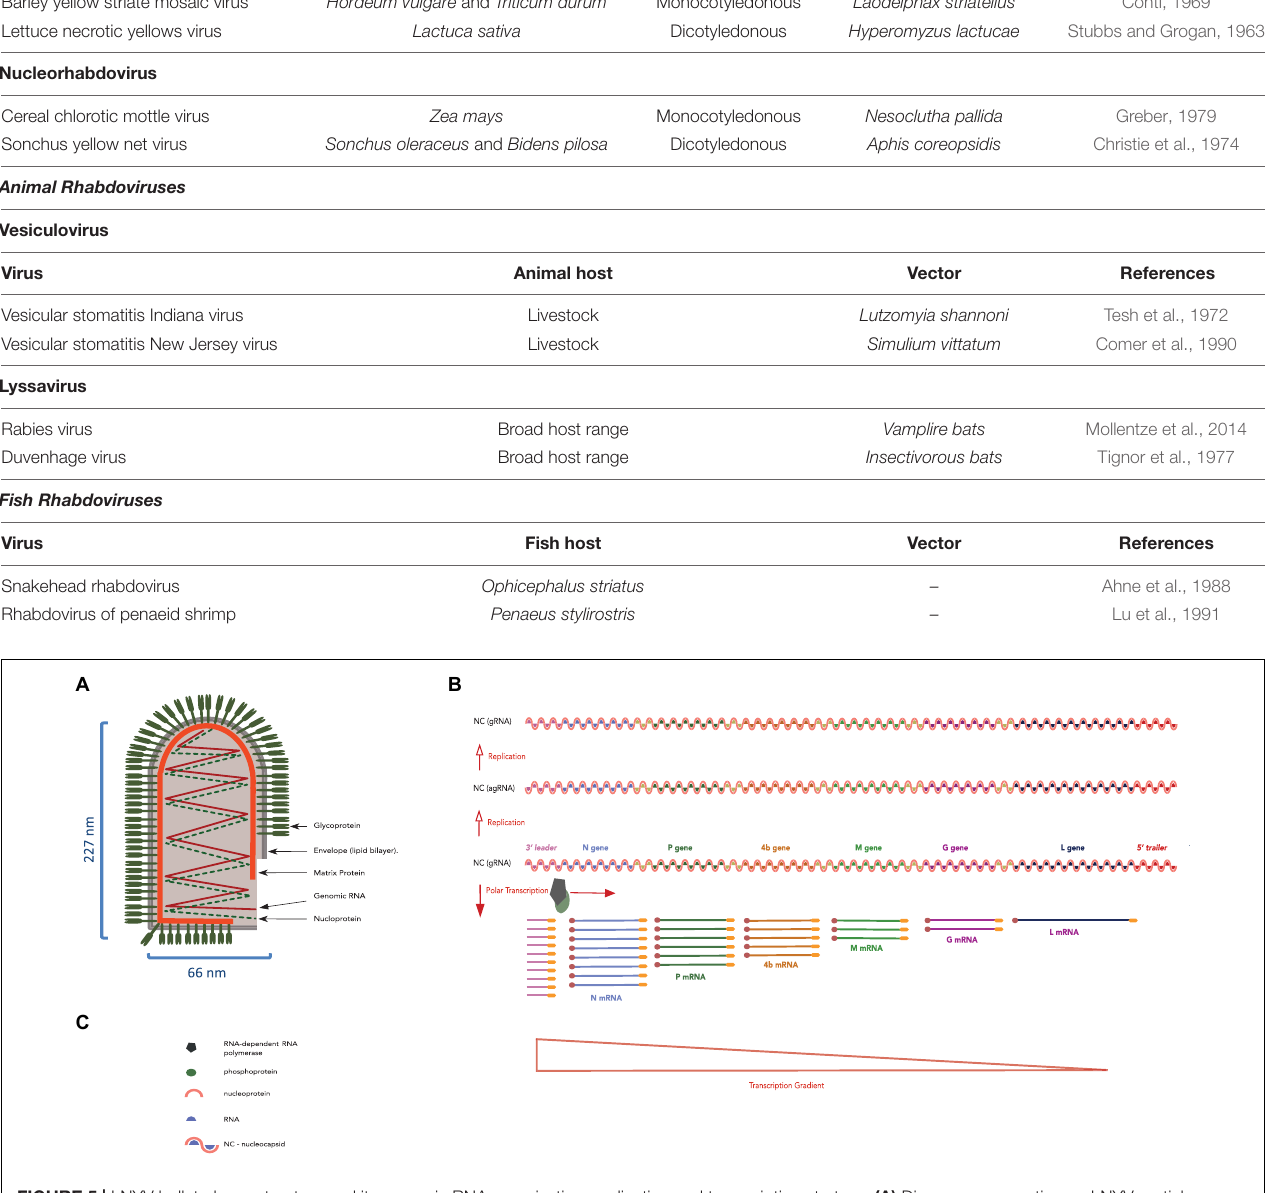
FIGURE 5 | LNYV bullet-shape structure and its genomic RNA organization, replication and transcription strategy. (A) Diagram representing an LNYV particle showing the transmembrane glycoprotein, lipid bilayer, matrix protein, and genomic RNA together with the nucleoprotein forming the ribonucleoprotein coil. (B) LNYV gRNA (negative-sense) showing the 3 (cid:48) leader , the N, P, 4b, M, G, and L genes, the 5 (cid:48) trailer (sequential genes separated by a gene junction) and the transcription gradient. Genomic RNA is first replicated into agRNA (positive-sense), which is used as template for the production of (accumulating amounts of) progeny gRNA (negative-sense). (C) Legend of panel (B)